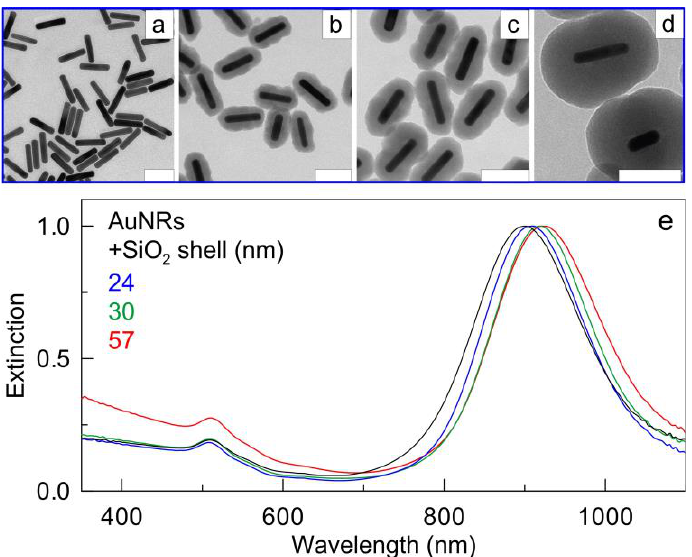
Figure 3. TEM images of AuNRs before ( a ) and after coating with the silica shell of 24 ( b ), 30 ( c ), and 57 ( d ) nm. Scale bars are 100 nm. Normalized extinction spectra ( e ) of AuNRs (black) and AuNR@SiO 2 composites. Note increased short-wavelength extinction for 57 nm silica shell due to scattering contribution.